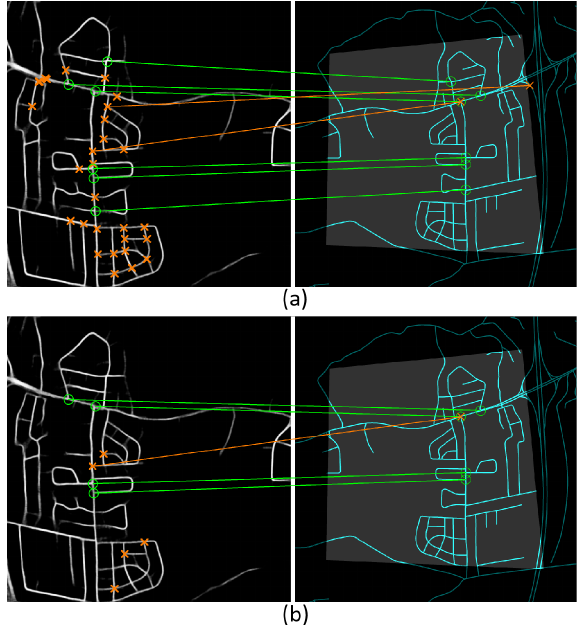
Figure 8. Matching result of the PICF for one road map before ( a ) and after ( b ) graph-cut optimization. The query road map is projected onto the reference road map with a padding of 200 m, and the projection areas are highlighted in gray. The projection images (right) are resized to the same height as the query road images (left). The correctly matched PICFs are marked with green circles, while those incorrectly matched are marked with orange crosses. The correct correspondences are shown in green, while the incorrect correspondences are shown in orange. The incorrect correspondences whose PICF centers in the reference road map fall out of the projection area are not shown with lines.